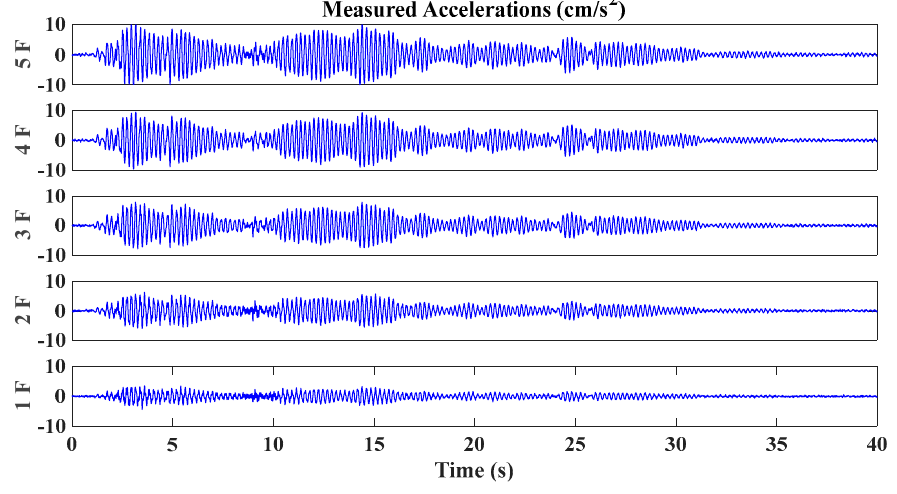
Figure 5. Time histories of simulated acceleration excited by El Centro earthquake record.